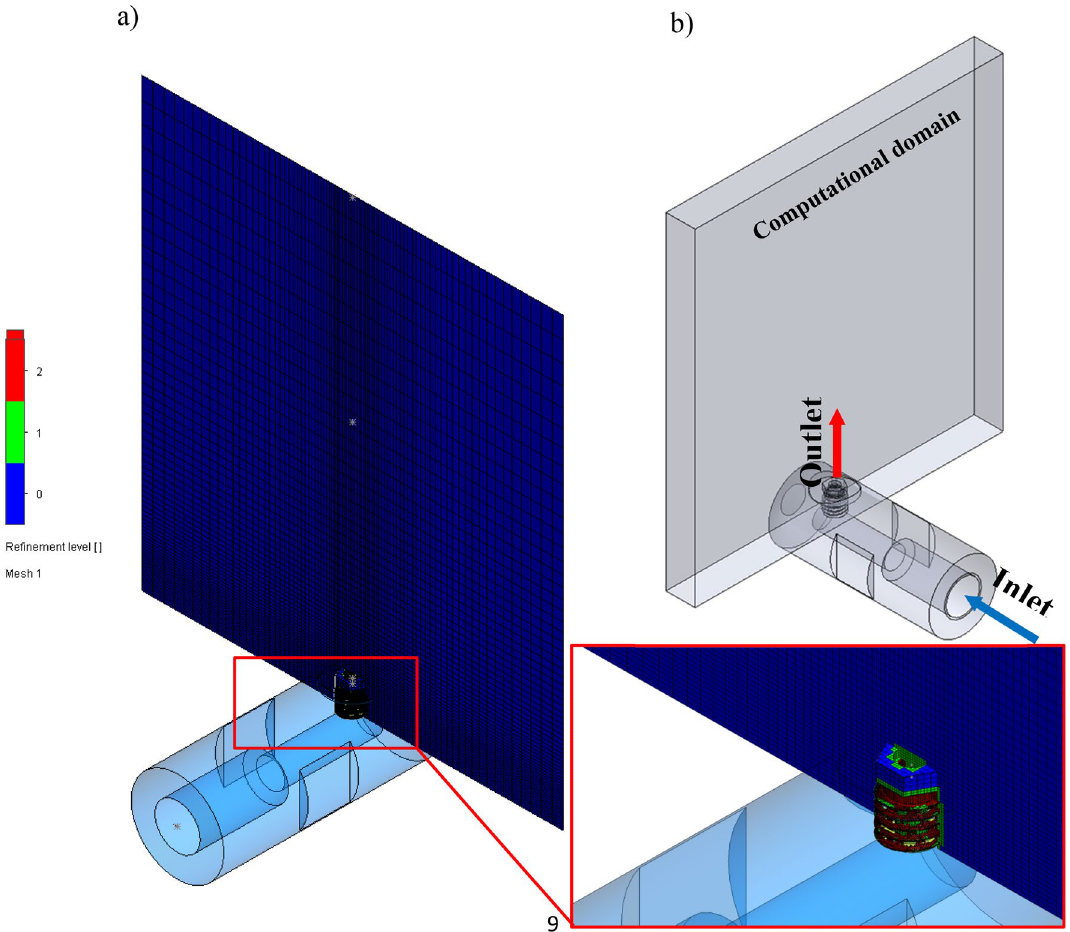
Figure 8. Numerical grid of the nozzle: ( a ) numerical grid, ( b ) computational domain